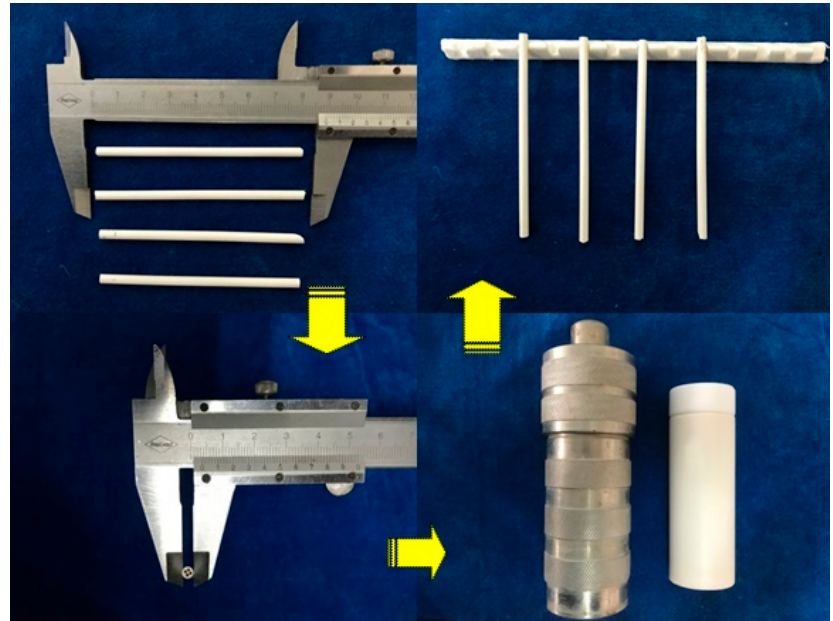
Figure 1. Cation treatment diagram of NaA zeolite membranes.